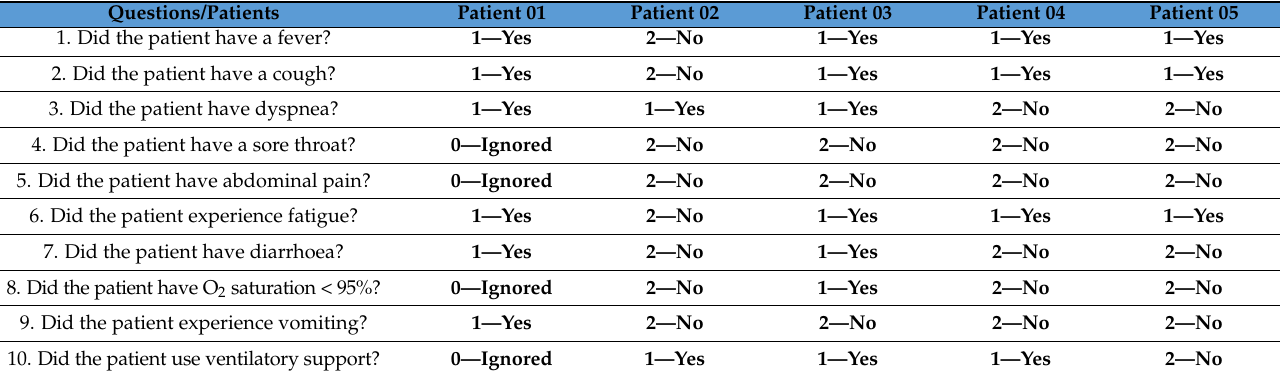
Table 12. Prediction of clinical